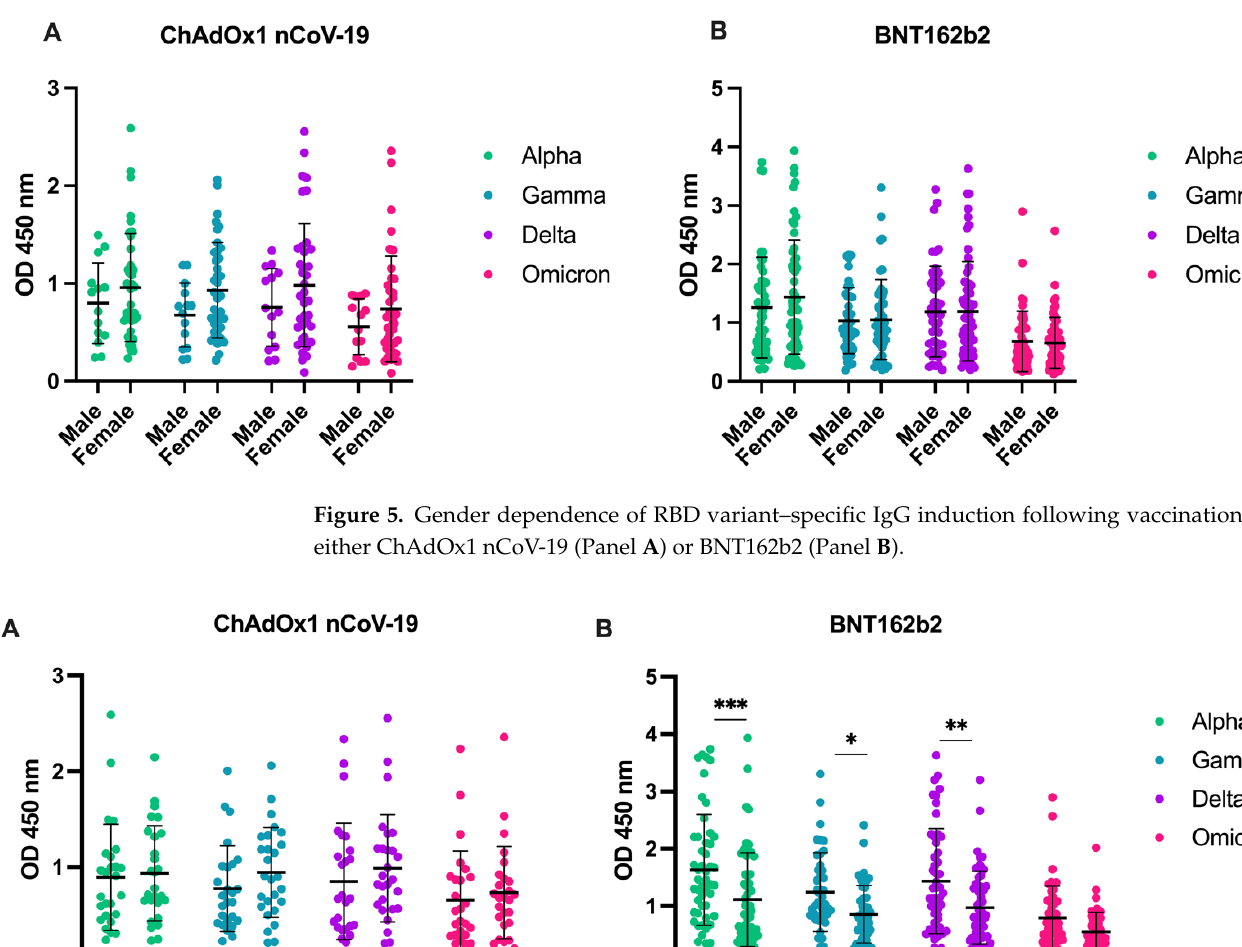
Figure 6. Age dependence of anti-RBD IgG against variants Alpha, Gamma, Delta, and Omicron.